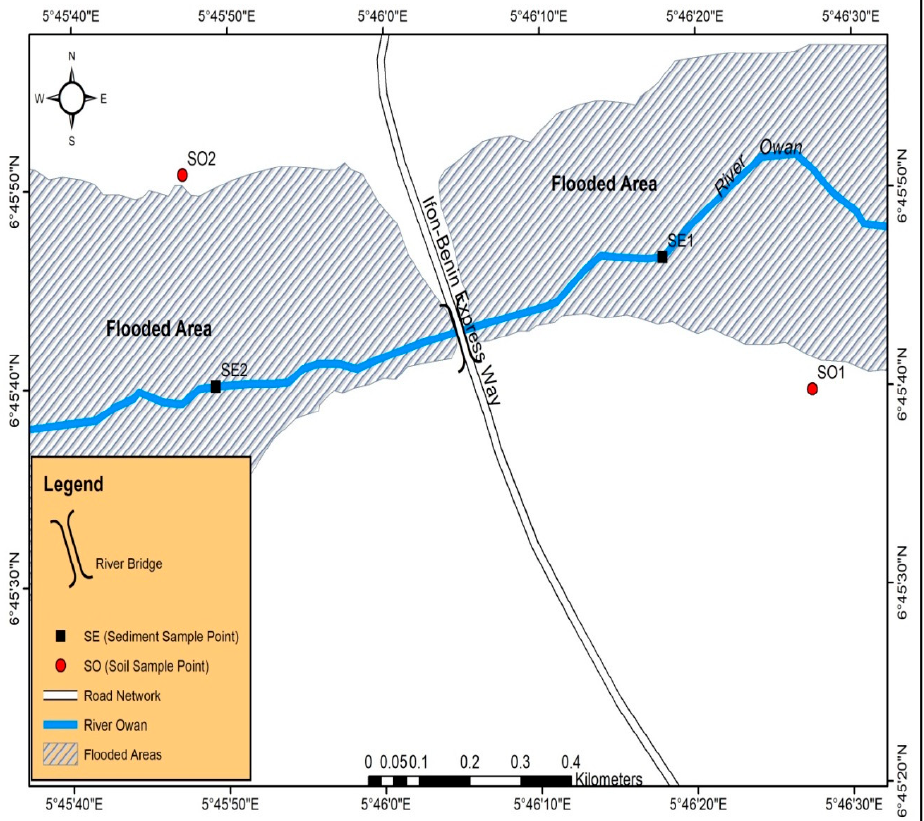
Figure 1. Map of the study area and sampling points. Source: This study